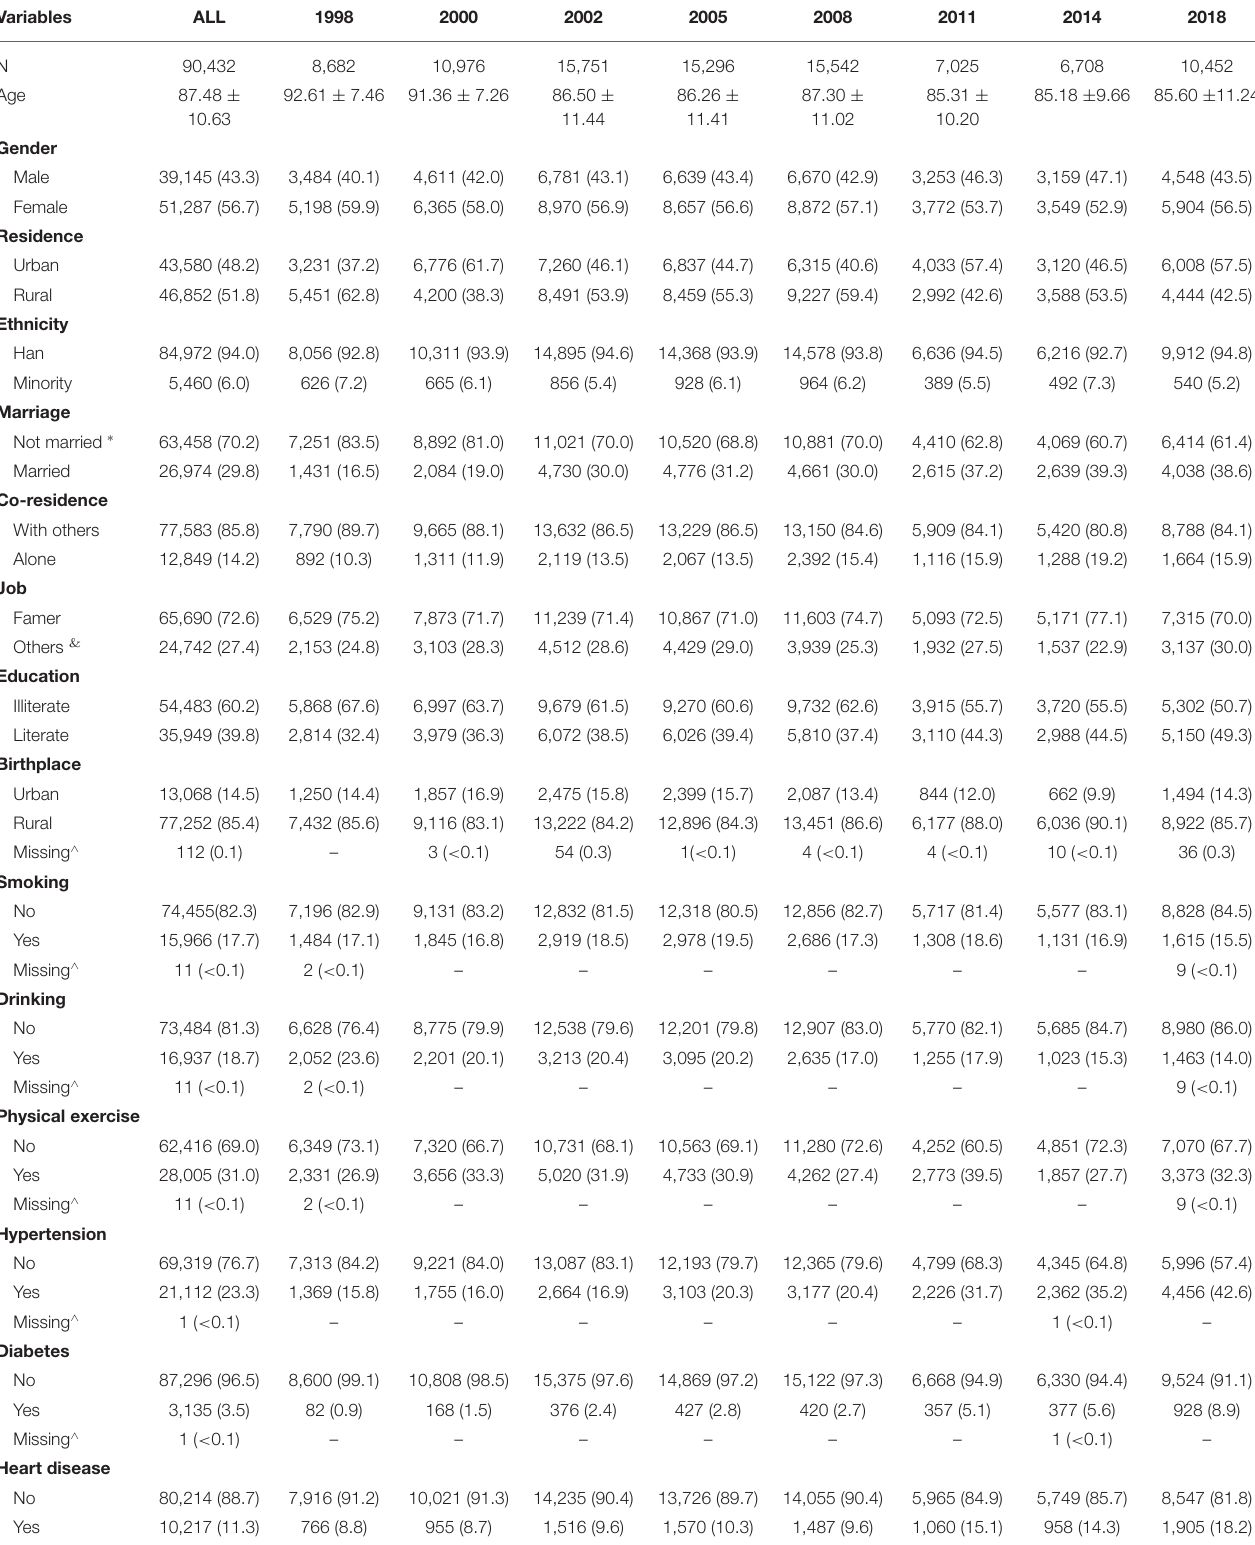
TABLE 1 | Basic characteristics of samples in the eight